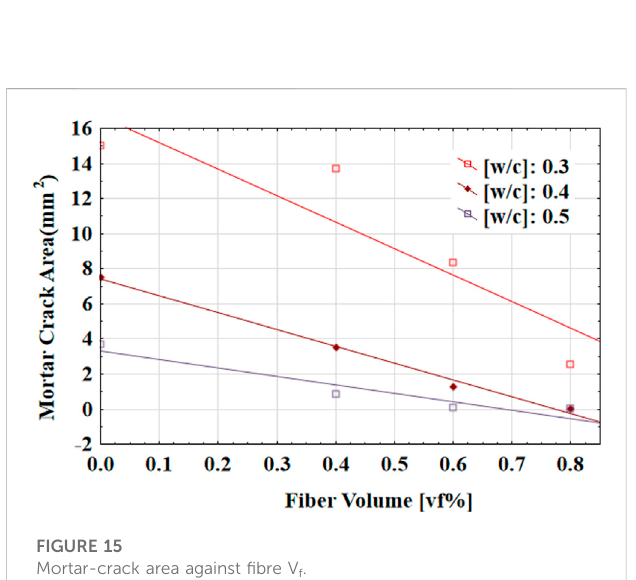
FIGURE 15 Mortar-crack area against fi bre V f . FIGURE 16